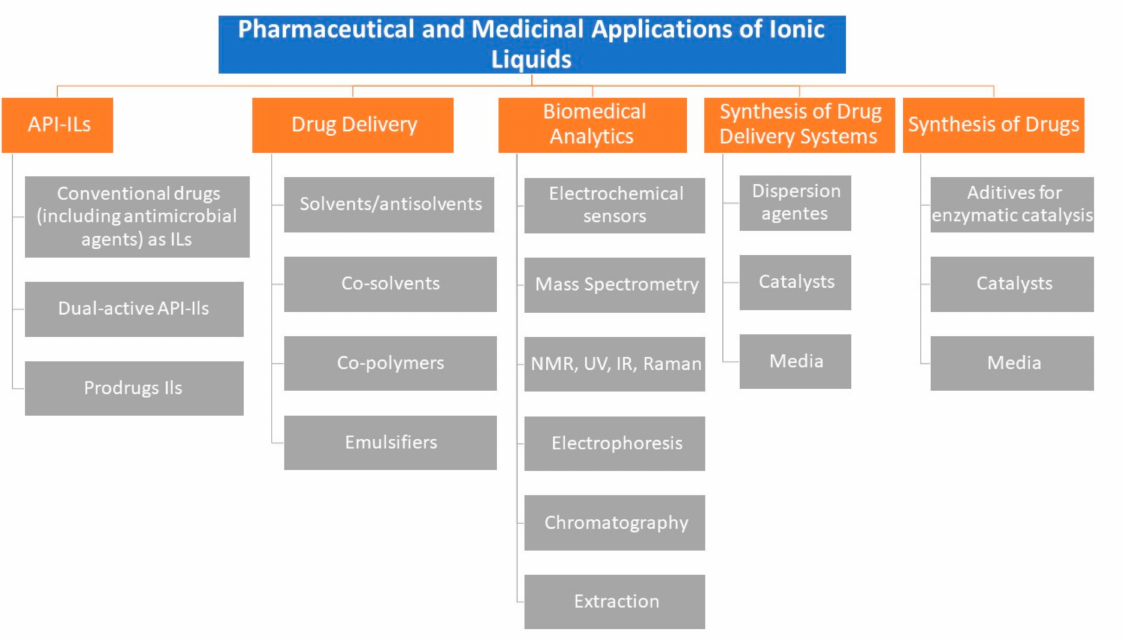
Figure 2. A summary of the many pharmaceutical and medicinal applications of ILs (adapted from Egorova et al. [31]). API: active pharmaceutical